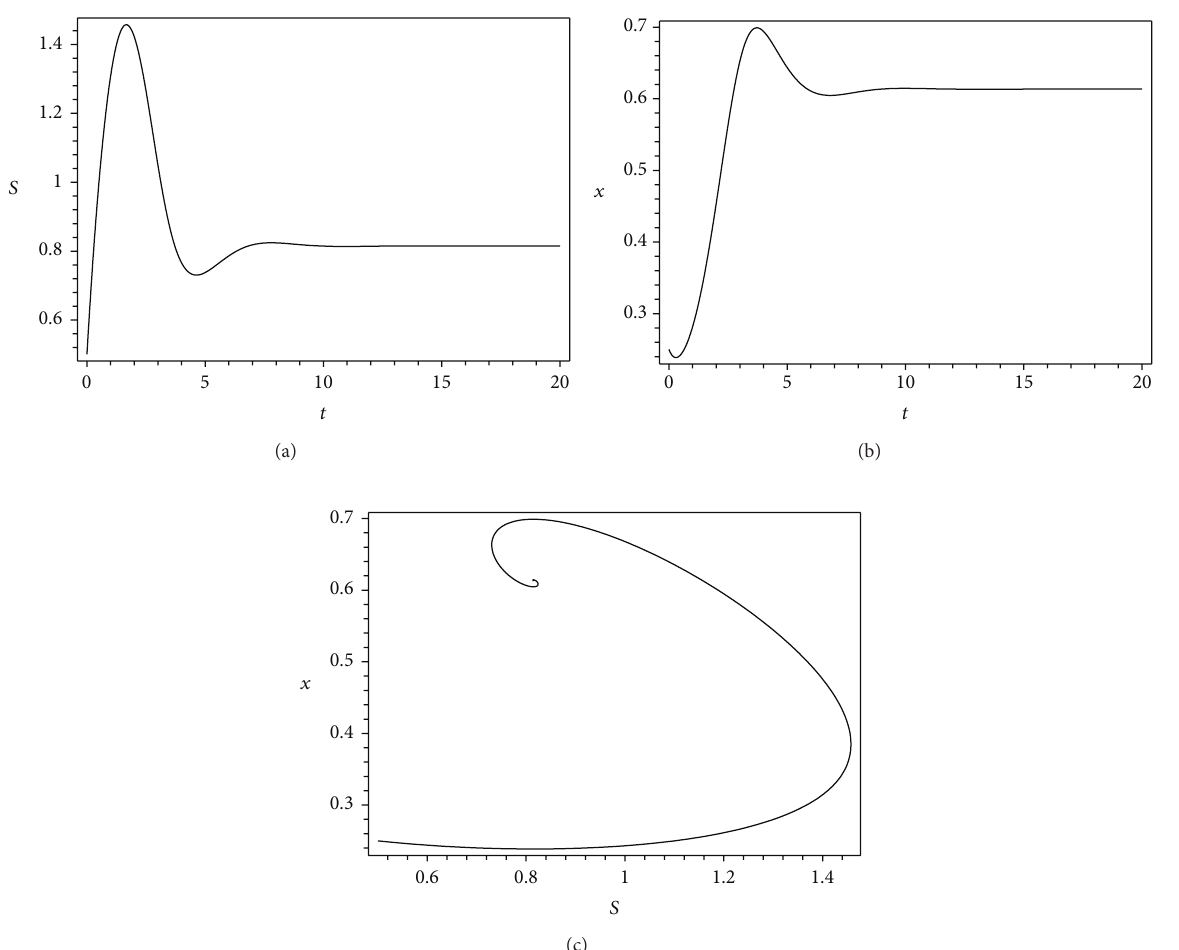
Figure 4: Time series and phase portrait of system (2) with 𝛿 1 = 0.6 , 𝐾 𝑠 = 2 , 𝑆 𝑖 = 4.7 , 𝐷 = 0.4 , 𝜇 = 3.8 , 𝐾 𝑑 = 0.7 , 𝑏 = 0.8 , 𝑆 0 = 0.5 , 𝑥 0 = 0.25 , and ℎ = 0.78 > 𝑆 ∗